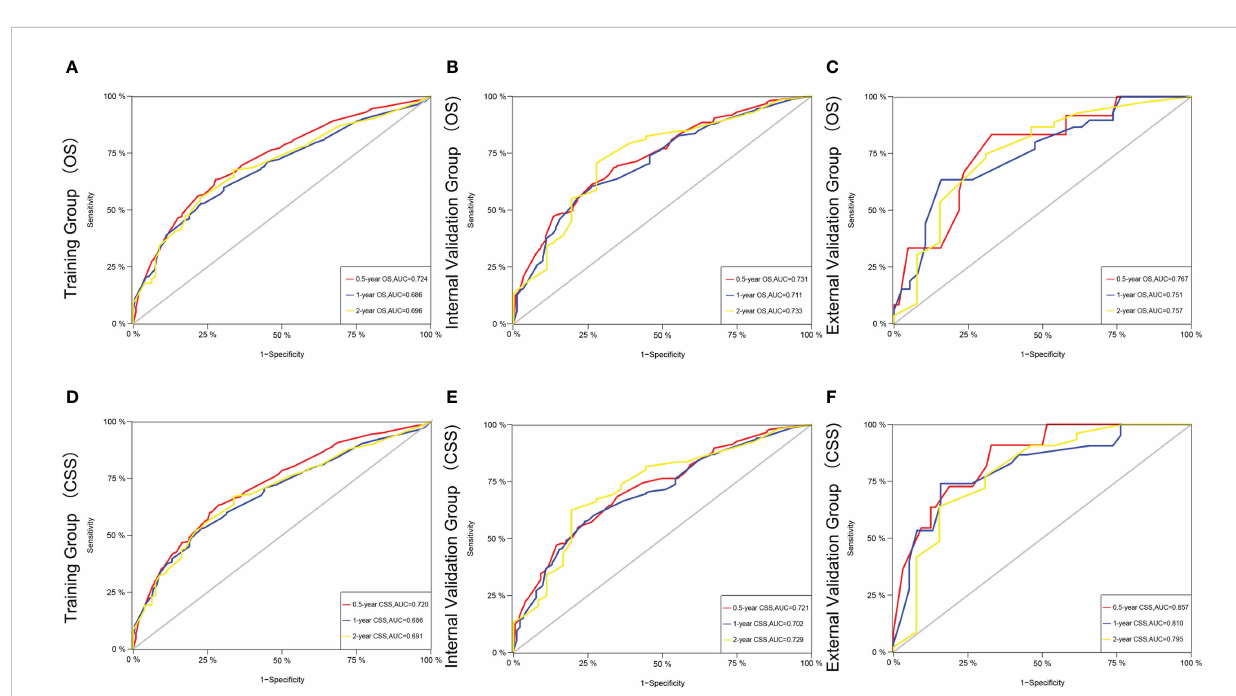
FIGURE 3 The time-dependent ROC curves of the nomogram predicting OS at (A) 0.5-year and 1-year and 2-year in the training cohort, and at (B) 0.5-year and 1-year and 2-year in the internal validation cohort, (C) 0.5-year and 1-year and 2-year in the external training cohort. The time-dependent ROC curves of the nomogram predicting CSS at (D) 0.5-year and 1-year and 2-year in the training cohort, and at (E) 0.5-year and 1-year and 2-yearin the internal validation cohort, (F) 0.5-year and 1-year and 2-year and 5-year in the external training